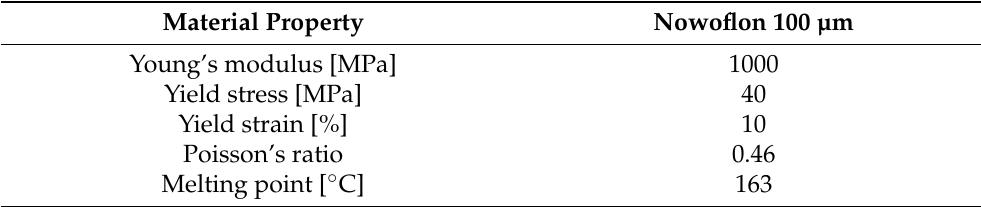
Table 1. PVDF Properties.